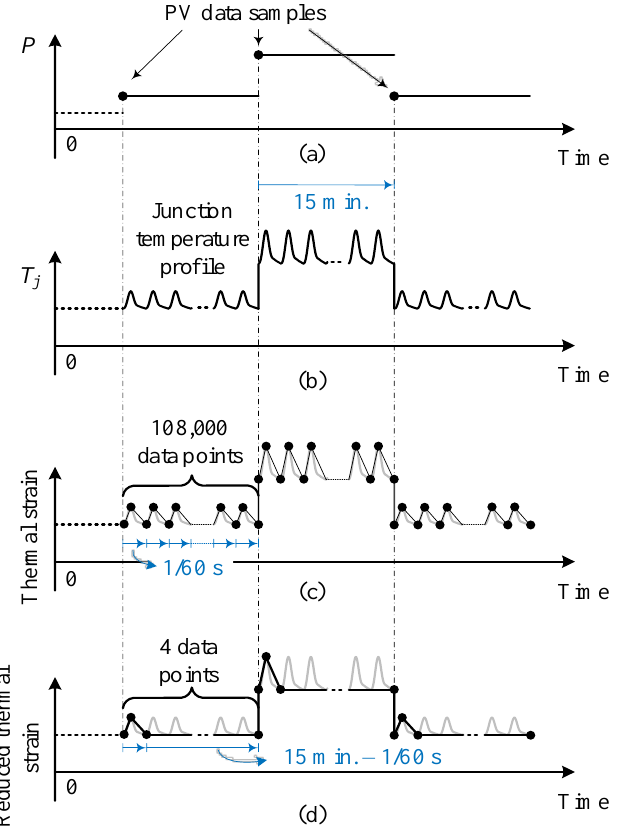
Figure 6. Thermal profile preparation for rainflow counting. ( a ) PV solar incidence data; ( b ) IGBT/diode junction temperature; ( c ) complete peak–valley profile; and ( d ) reduced peak–valley profile.